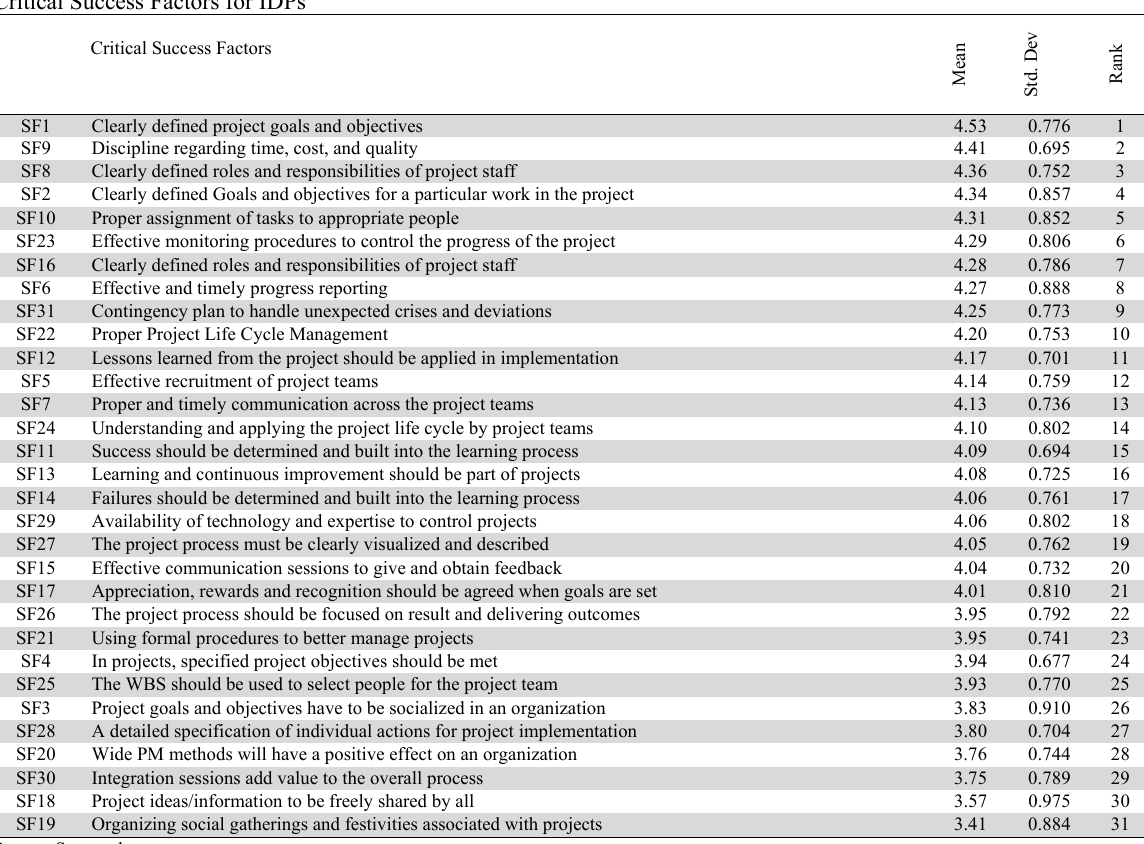
Critical Success Factors for IDPs